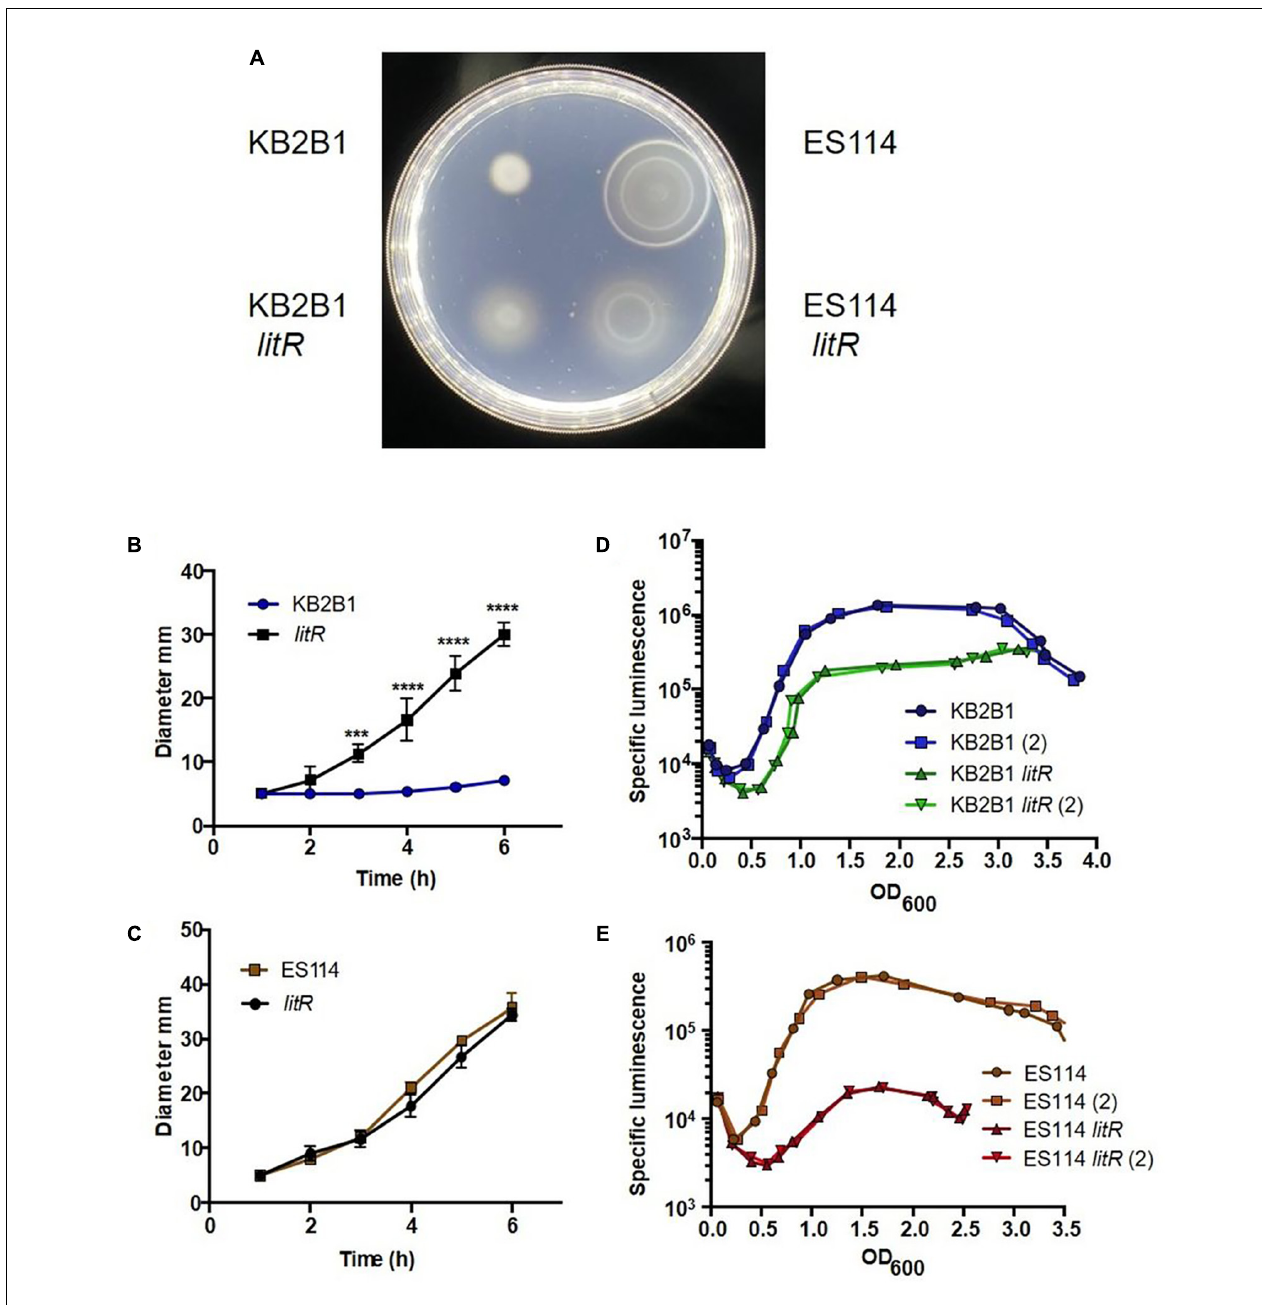
FIGURE 6 | Motility and luminescence of litR null mutant strains. (A) Photograph of the motility, taken at 5 h post-inoculation, on TBS-Mg 2 + agar of KB2B1 and its litR derivative (KV9023) on the left and of ES114 and its litR derivative (JB19) on the right. (B,C) Measurements of the size of the diameter of the migrating cells over time for KB2B1 and KV9023 (B) and ES114 and JB19 (C) . (D,E) The levels of specific luminescence (relative light units divided by optical density) graphed vs. optical density (OD 600 ) of KB2B1 and its litR derivative (KV9023) (D) and ES114 and its litR derivative (JB19) (E) . Luminescence experiments were performed with duplicate cultures. Statistics were done via two-way ANOVA. *** p = 0.0003; **** p <